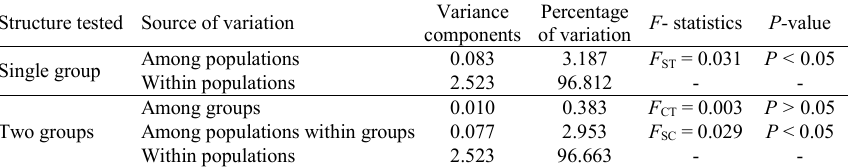
Table 8. Analysis of Molecular Variance (AMOVA) among sampling groups of Prochilodus costatus . Structure tested: All samplings as a single group and divided in two groups: group 1 (Mainstream ABAr, TMDd and TMDr) and group 2 (Marginal lagoons of PAR and